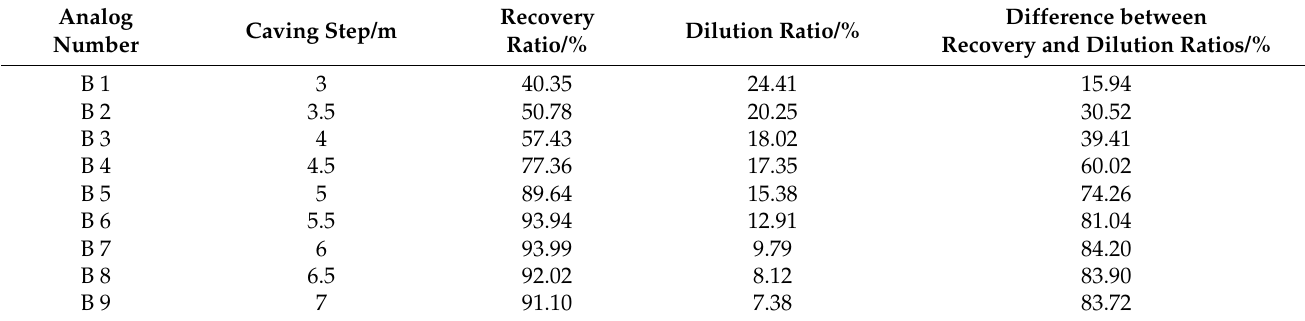
Table 6. Results of recovery indexes in the optimization simulation of caving step.